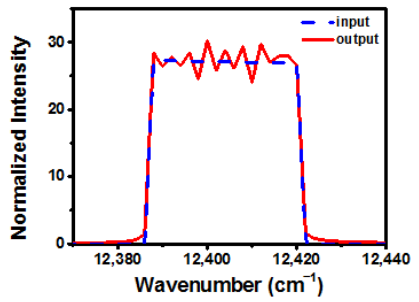
Figure 12. Spectra of the input and the response of the Stokes pulse.